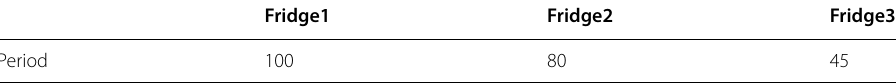
Fridge1 Fridge2 Fridge3 Period